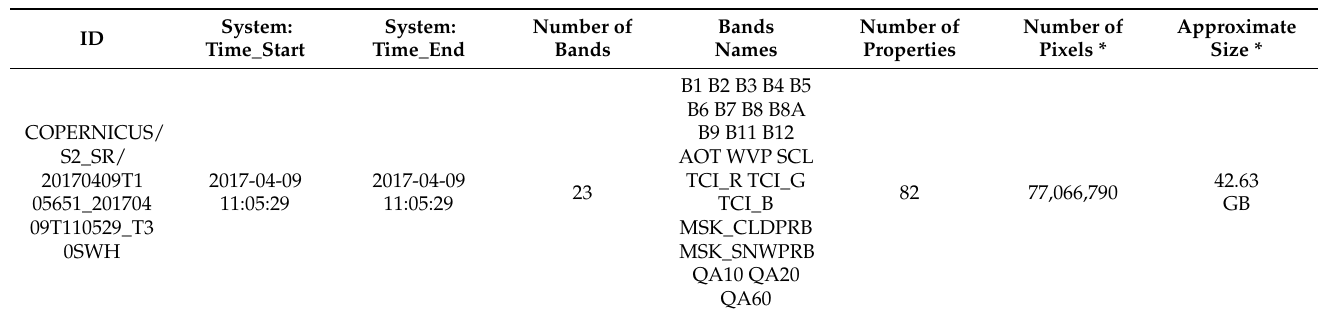
Table 7. Earth Engine COPERNICUS/S2_SR mosaic clipped on